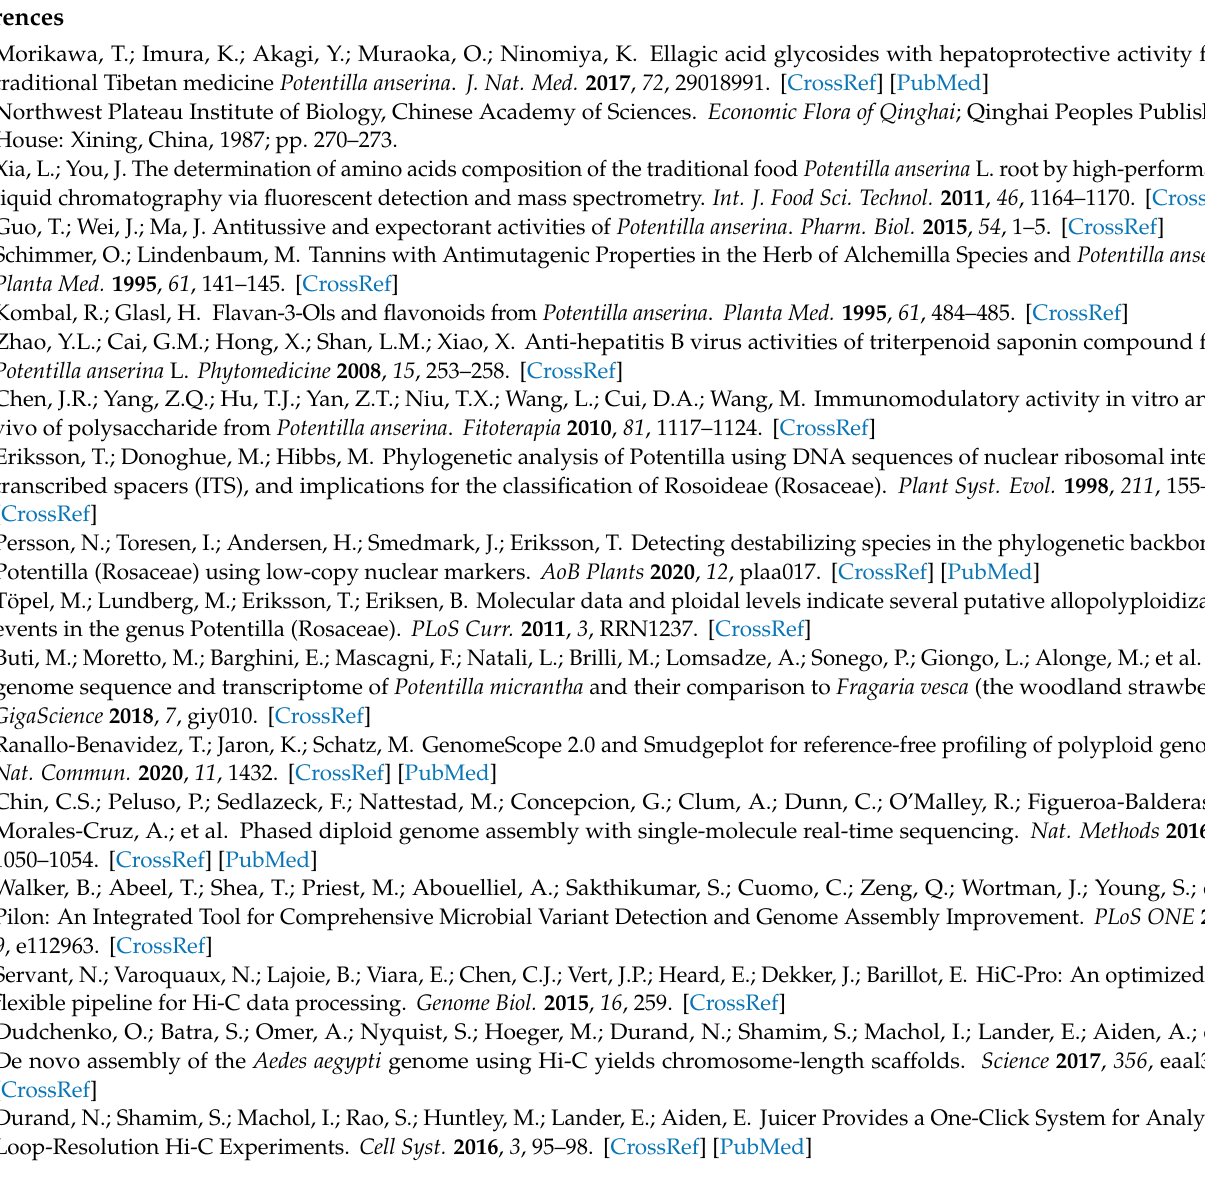
Table S10. Characterized R genes in F. vesca, P. anserina and P. micrantha , Table S11. The expression level (TPM) of key genes related to starch metabolism, Table S12. The key genes involved in tannin, flavonoid and triterpenes metabolism in